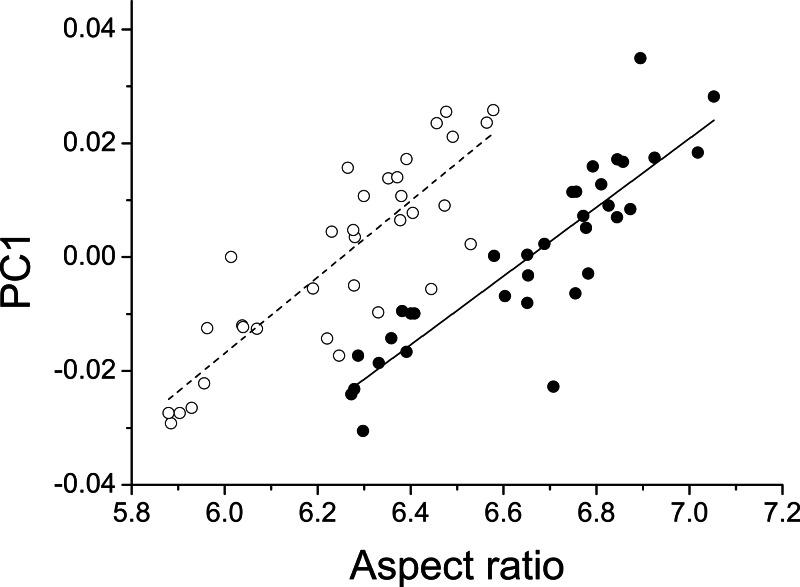
Aspect ratio vs. geometric morphometrics.Relationship between aspect ratio and the first principal component describing variation in wing shape for fore (closed symbols, solid line) and hind wings (open symbols, dotted line) in Calopteryx maculata. Points are mean values from each of 34 sampling sites for both variables.